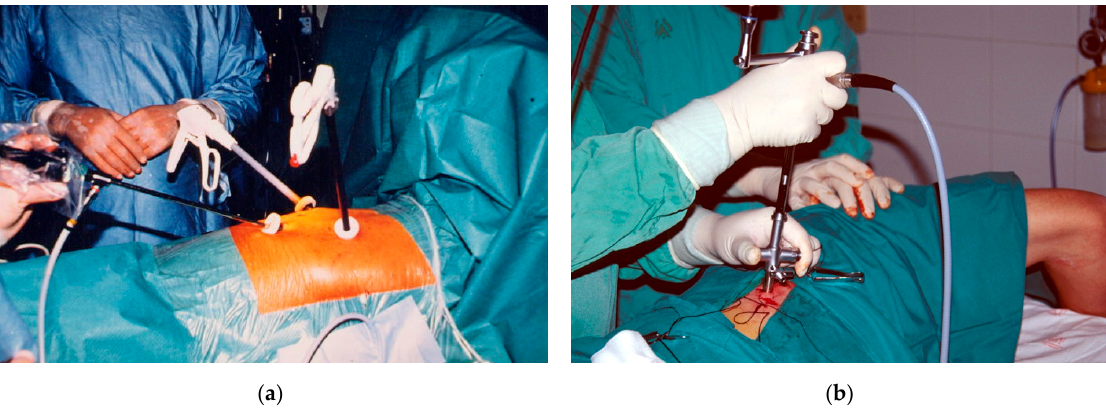
Figure 1. Thoracoscopic techniques. ( a ) Triportal VATS under general anesthesia; ( b ) Medical thoracoscopy under conscious sedation, using a rigid instrument. Table 3. Medical thoracoscopy versus surgical